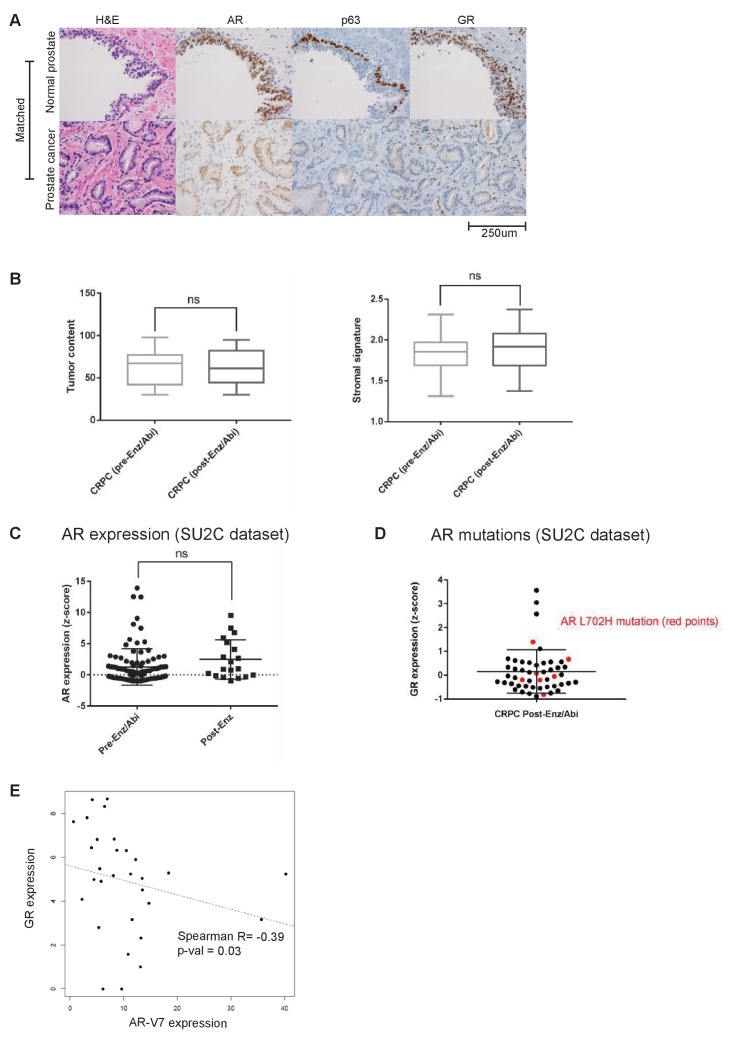
Analysis of GR expression in multiple datasets and primary patient samples.(A) Hematoxylin and eosin stain and immunohistochemistry for AR, p63, and GR in a paraffin-embedded patient-matched normal prostate and prostate tumor samples. This figure is representative of five matched normal-tumor pairs, which show the same pattern of staining. (B) Computational tumor purity metrics using the ABSOLUTE method and a stromal signature score (explained further in methods). (C) AR expression in SU2C dataset (Karthaus et al., 2014) in CRPC pre-Enz/Abi [n = 62] and CRPC post-Enz [n = 19] samples. (D) GR expression in individual post-Enz/Abi CRPC tumors. Red dots indicate tumors with AR L702H mutation. (E) Correlation between GR expression and AR-V7 expression in post-Enz/Abi patient samples. AR-V7 expression measured by normalized RNA-seq read counts across splice junction.